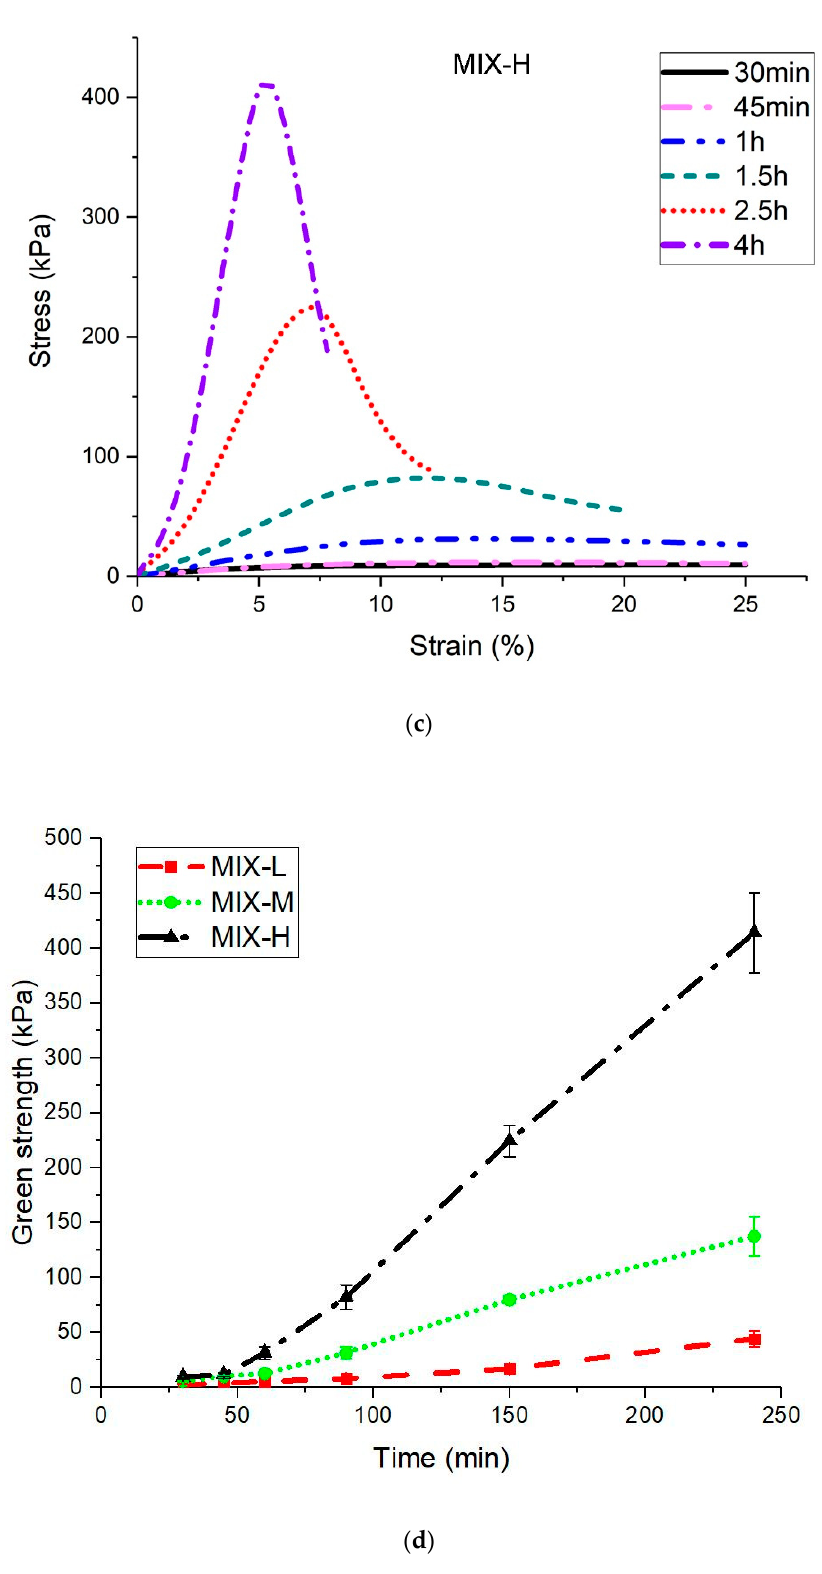
Figure 10. ( a ) The average stress and strain curve of mixture MIX-L; ( b ) The average stress and strain curve of mixture MIX-M; ( c ) The average stress and strain curve of mixture MIX-H; ( d ) Comparison of green strength of mix designs at different ages. The relative standard deviation (RSD) of peak stresses is under 20% which is similar to the findings of Wolfs et al . [30].